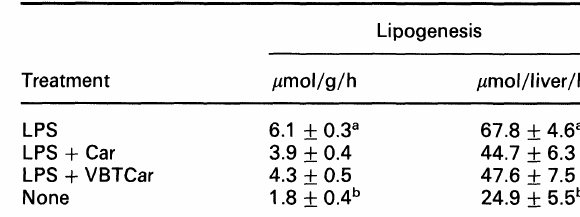
Table 3. The variation of body weight with time